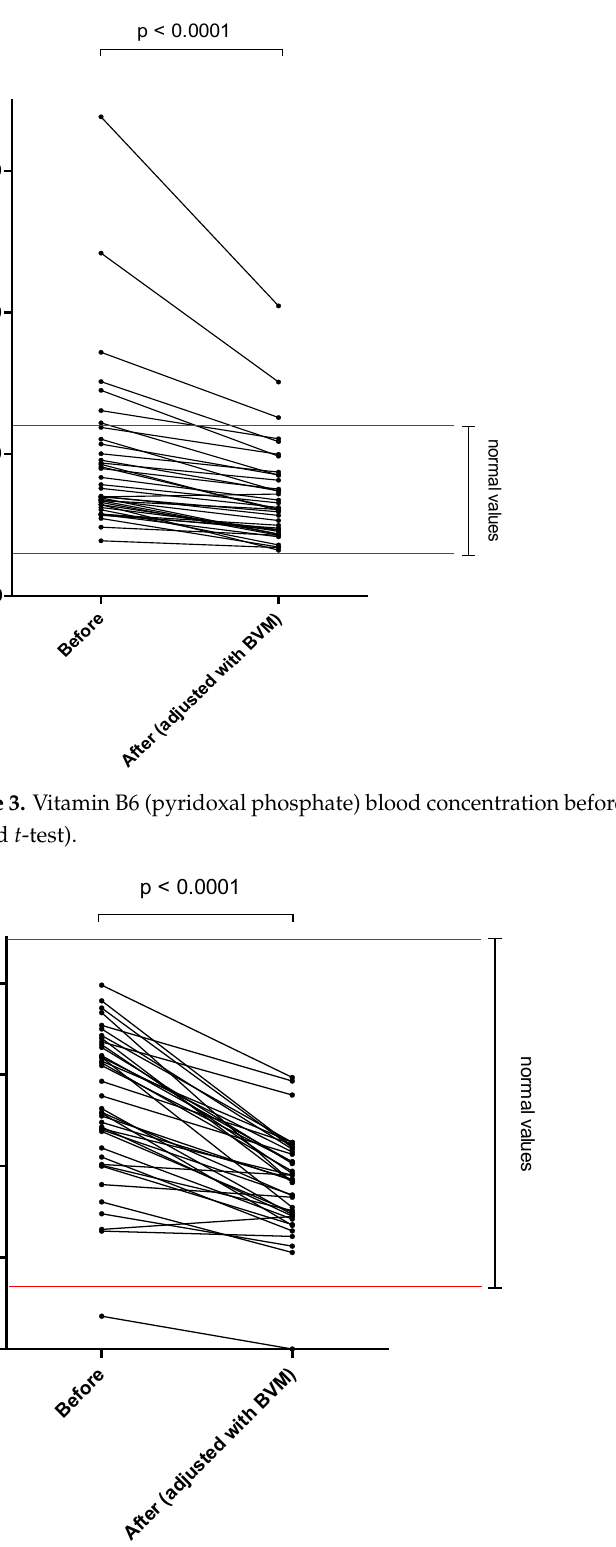
Figure 4. Vitamin B9 (folates) serum concentration before and after one 4 h-HDF session (paired t-test).